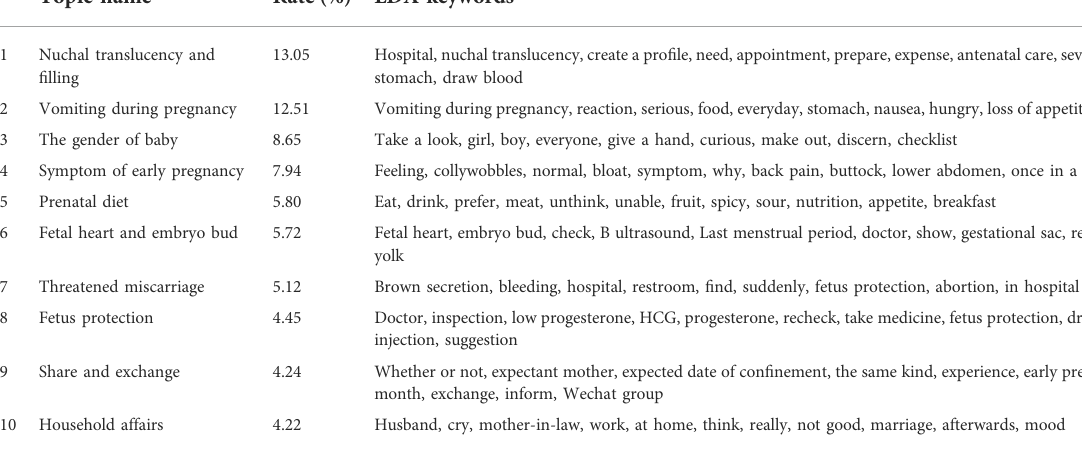
pregnant women ’ s body response during the early pregnancy period. The next two frequent topics are “ appeals and desire ” and “ question for help, ” at 12.54% and 10.96%, respectively.